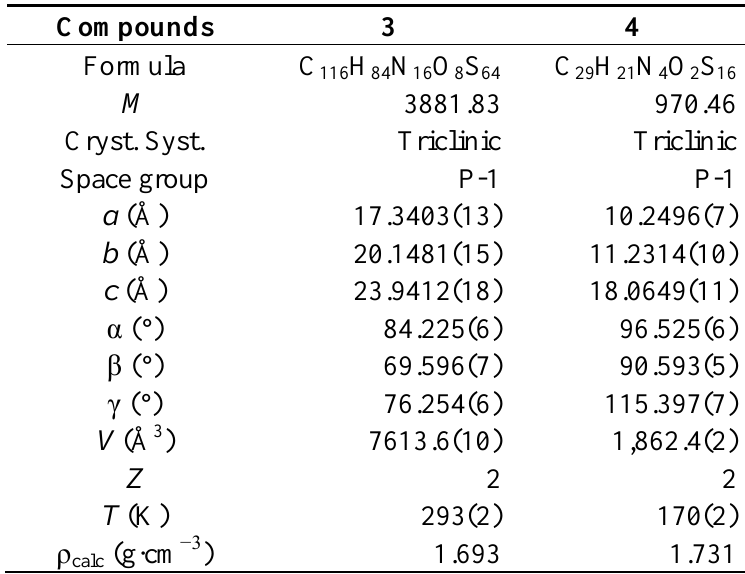
(tcnoetOH) ( 3 ) and β''-ET 2